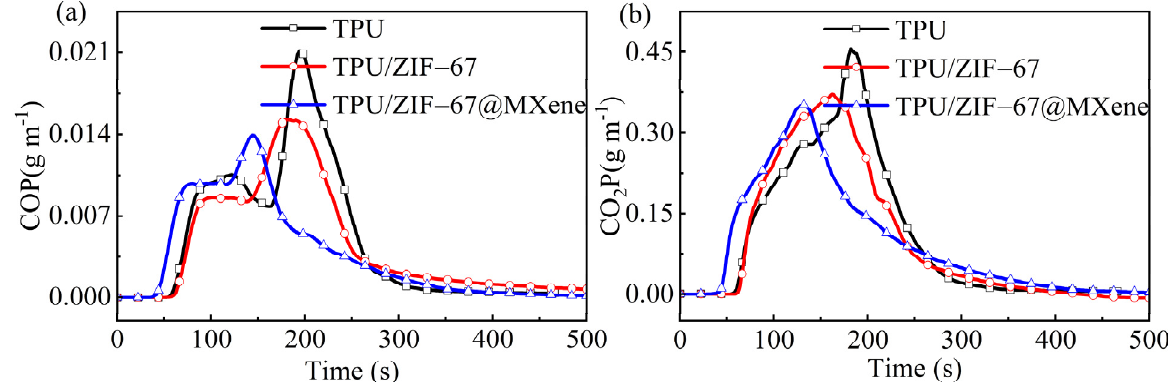
Figure 6. ( a ) CO and ( b ) CO 2 yield curves of TPU composites.